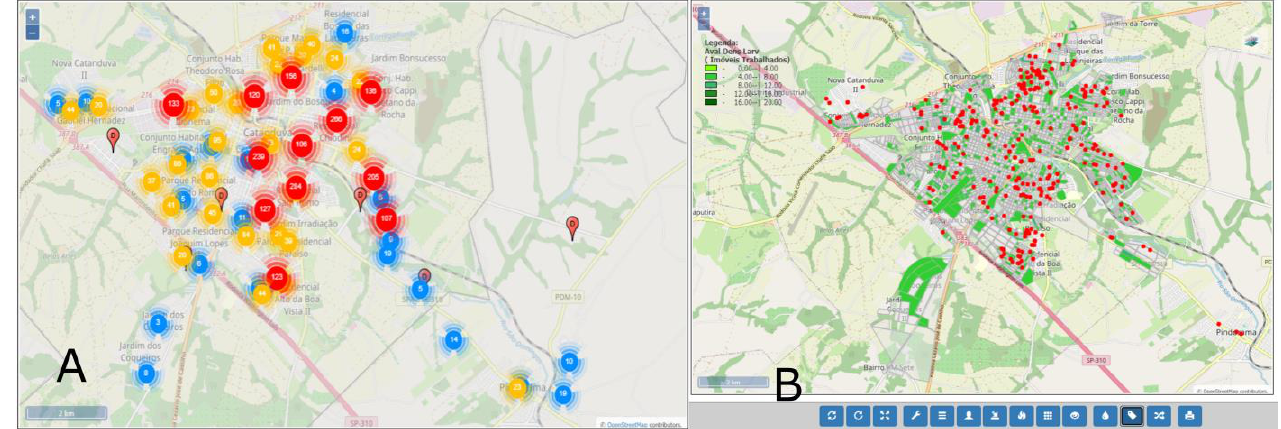
Figure 10 . ( A ) Distribution of the number of dengue cases (Source: Sinan) in a district from the county; ( B ) Distribution of dengue cases (red spots) and the range layer from Breteau Index—Evaluation of larval density in the county (green polygons). Note: Legenda = Subtitle; Aval. Den. Larv = Larvae Density Index.